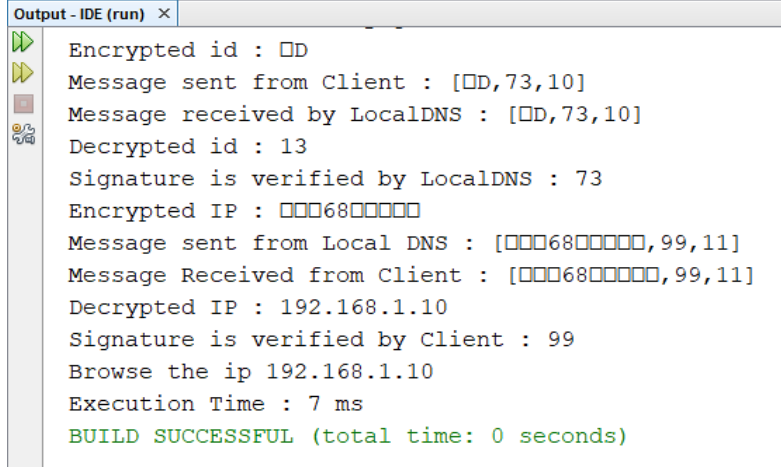
Figure 6. Encryption and Decryption Process at Client-Server